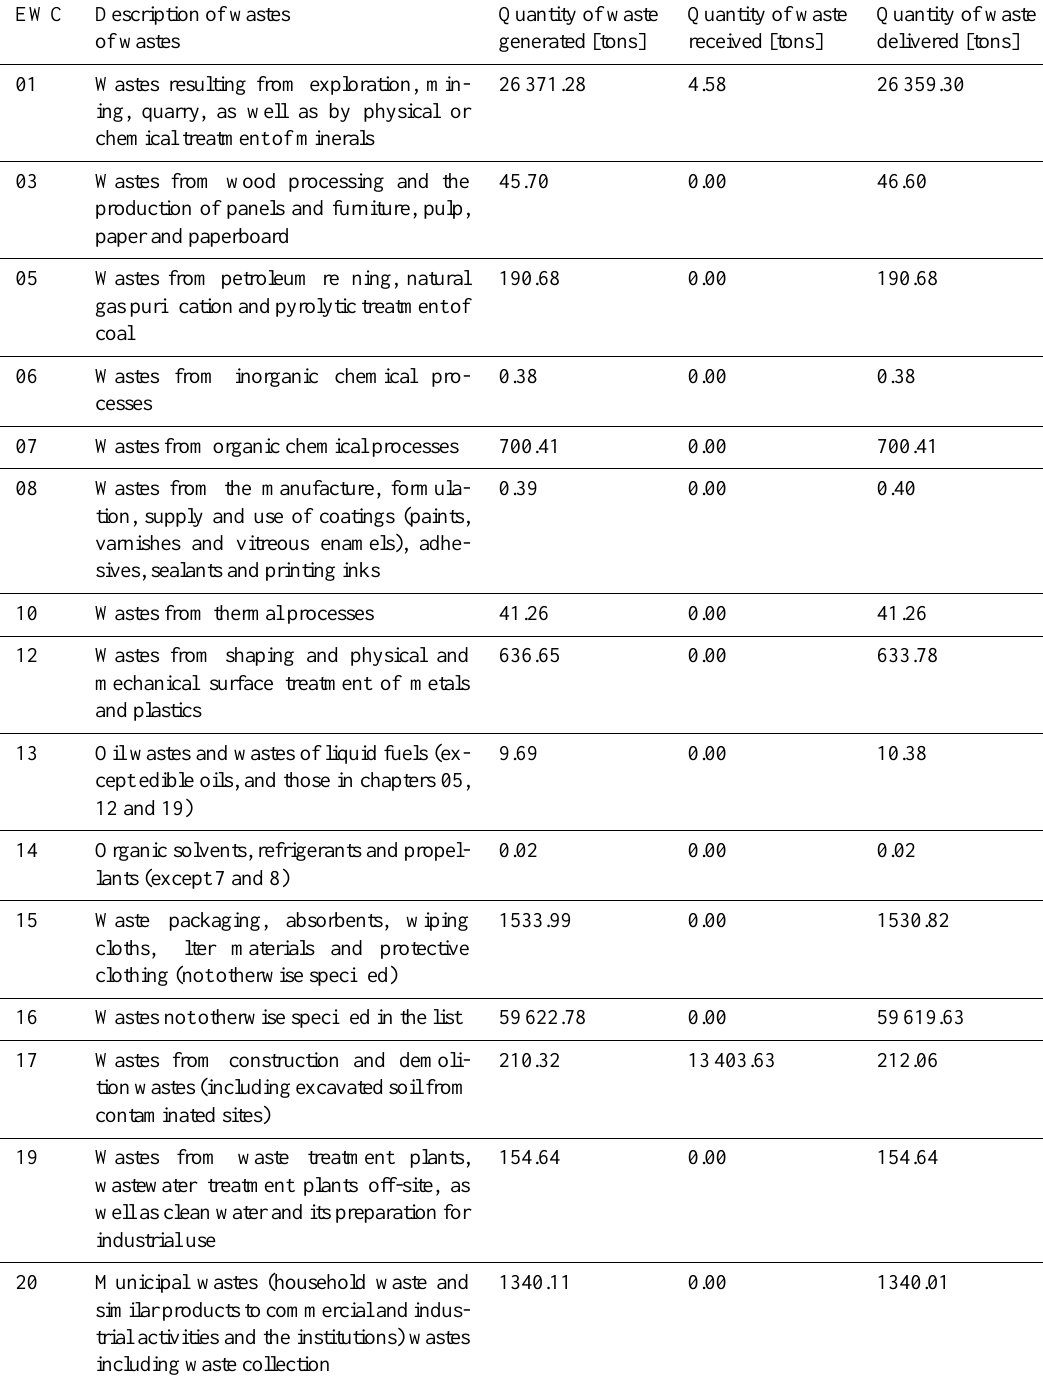
Table 5. Waste flows according to EWC classification (source: ARPAB internal communication). EWC Description of